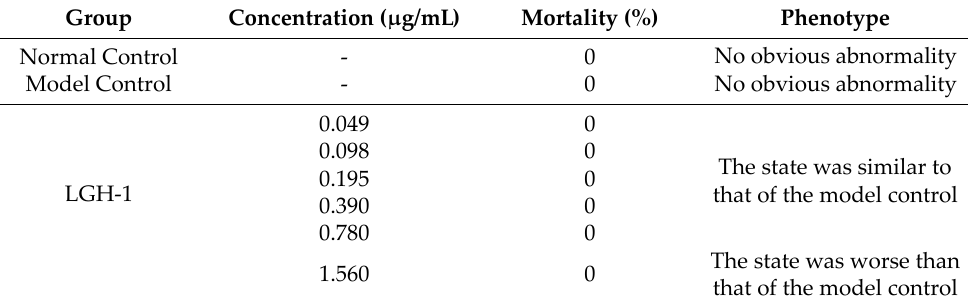
Table 1. MTC results of different concentrations of lutein (n = 30).